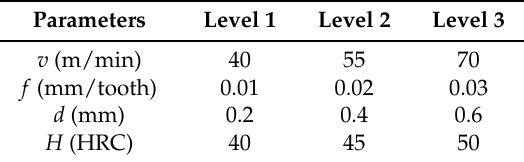
Table 8. Parameters and levels.